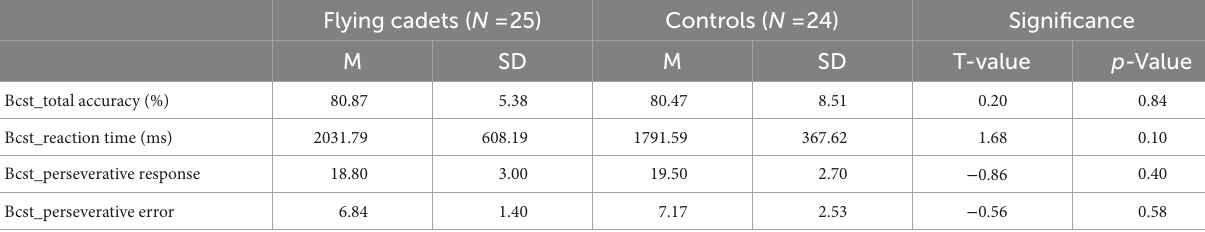
TABLE 2 Characteristics of the two groups at the second time